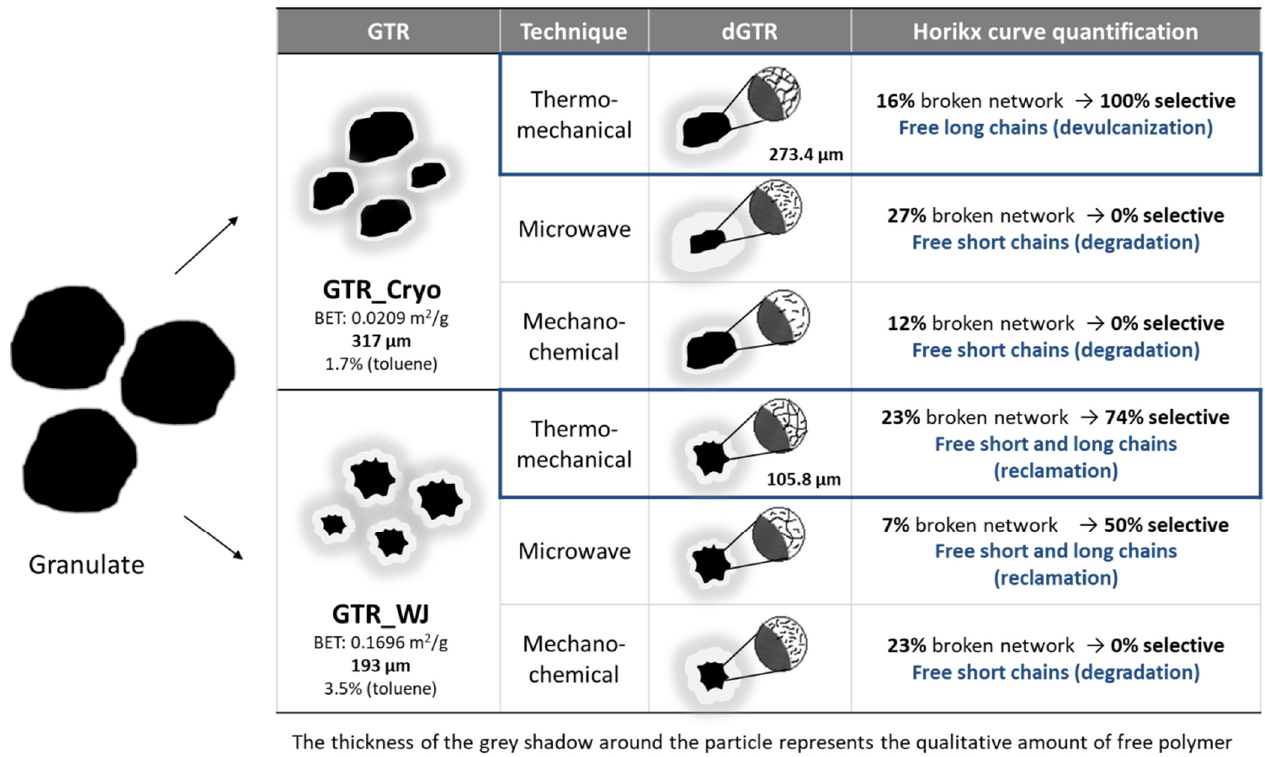
Figure 5. Representation of the microstructural evolution and main reclamation reactions.